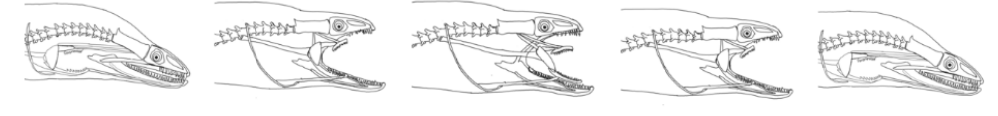
Figure 3. The approximate motion of the moray eel during hunting.